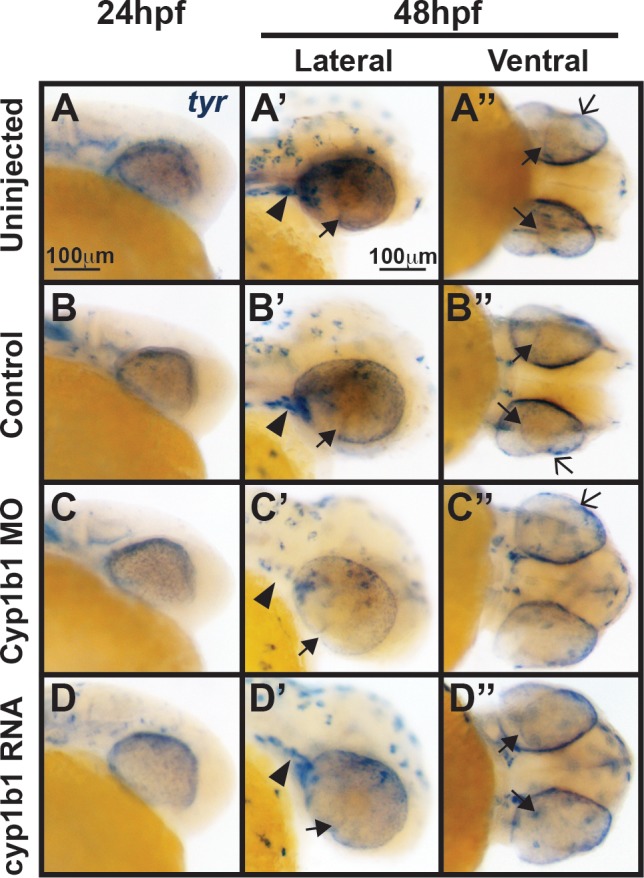
Tyr expression is not influenced by alterations in cyp1b1 expression. In situ hybridization demonstrated that at 24 hpf, tyr was expressed in the migrating neural crest and retinal pigment epithelium in uninjected (A) and control-injected (B) embryos. At 48 hpf, tyr expression (A', A'', B', B'') followed the skin pigmentation pattern and was also observed in the cranial neural crest (arrowheads), retinal pigment epithelium, migrating neural crest cells in the ocular fissure (closed arrows), and iris stroma (open arrows). Knockdown of cyp1b1 did not alter tyr expression at 24 hpf, but did decrease tyr expression in the cranial neural crest (arrowhead) and ocular fissure (C, C') at 48 hpf. Overexpression of cyp1b1 did not alter tyr expression (D, D', D'') at 24 and 48 hpf.